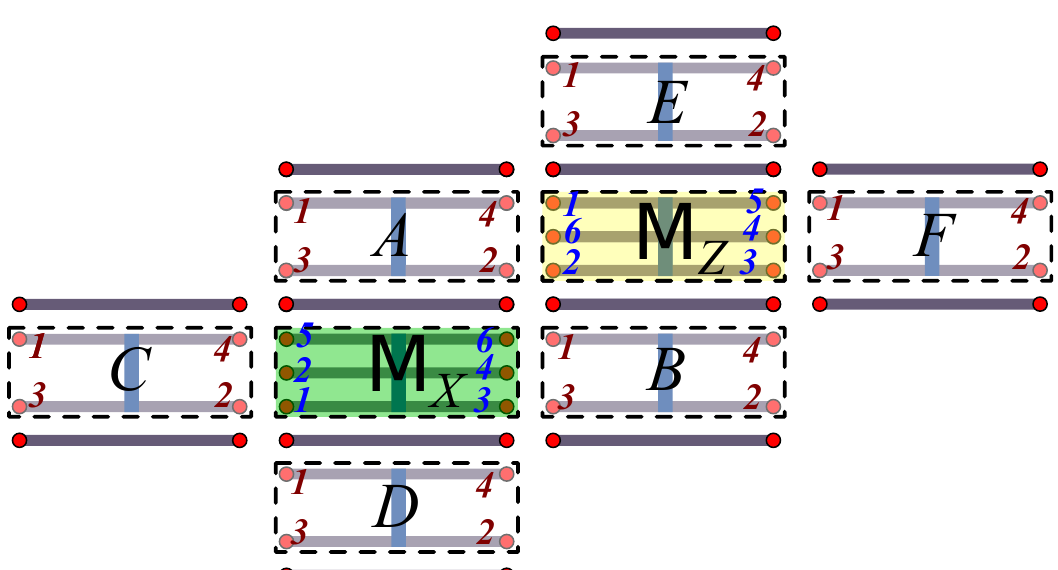
Figure 7: An example of an optimized labeling configuration for the proposed ar- chitecture. The tetrons (labeled A , B , C , D , E , F ) all use the 〈 1,3,2,4 〉 configuration, the M hexon (green) uses the 〈 5,2,1,3,4,6 〉 configuration, and the M X (yellow) uses the 〈 1,6,2,3,4,5 〉